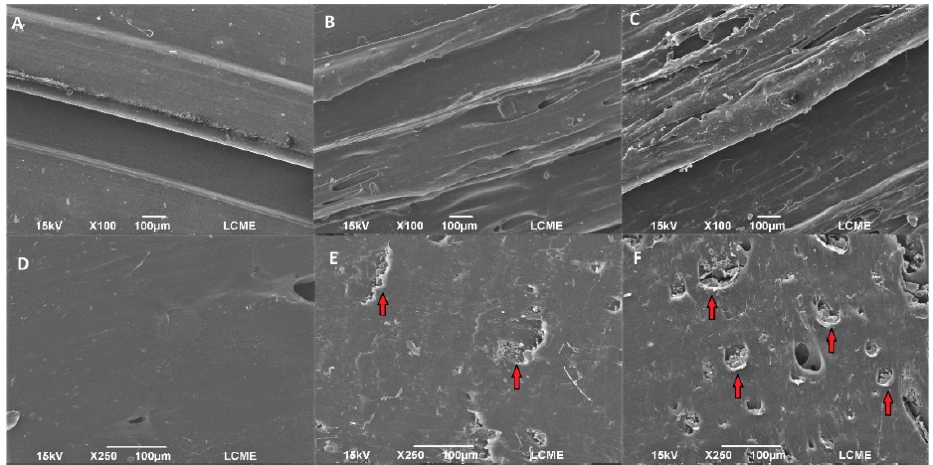
Figure 2. SEM images of surface ( top ) and cross-section ( bottom ) of 3D-printed intravaginal rings of EVA-P ( A , D ), EVA-P10 ( B , E ), and EVA-P20 ( C , F ).